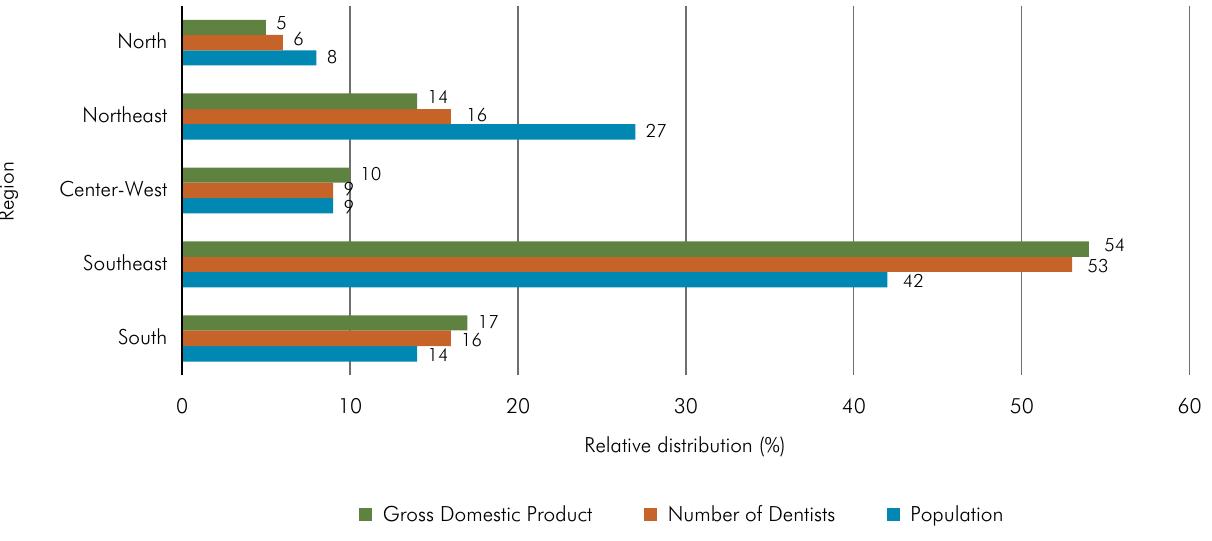
Figure 4. Relative distribution of dentists, population, and gross domestic product in the Brazilian geographic regions, obtained from CFO, 8 IBGE, 9 and IBGE. 10